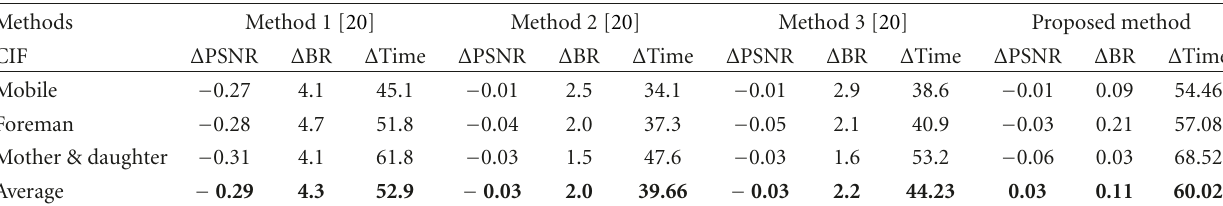
Table 4: Experimental Results of the proposed algorithm.